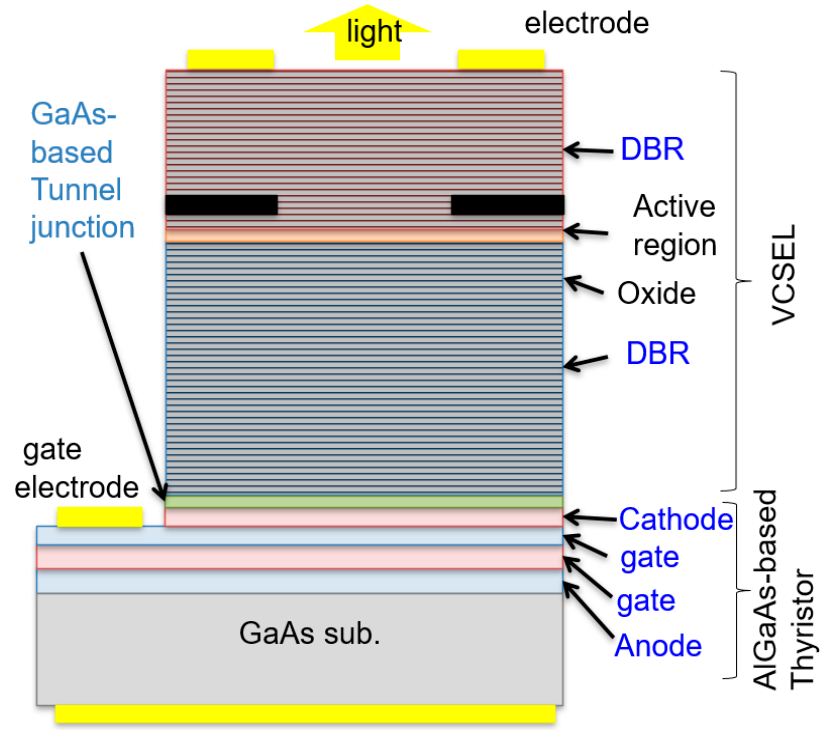
Figure 2. Cross-sectional view of a conventional top-emitting 940-nm oxide-confined VCSEL.